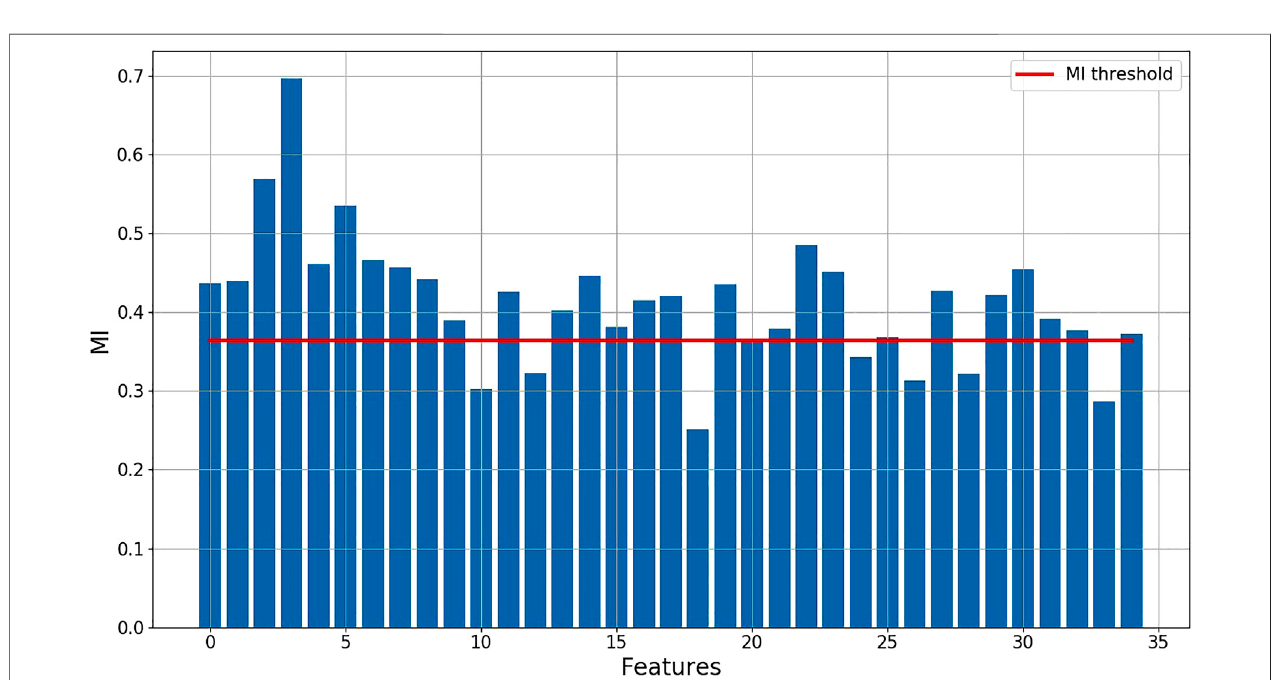
FIGURE 4 | MI of each data feature with the dependent variable and the value of the threshold.